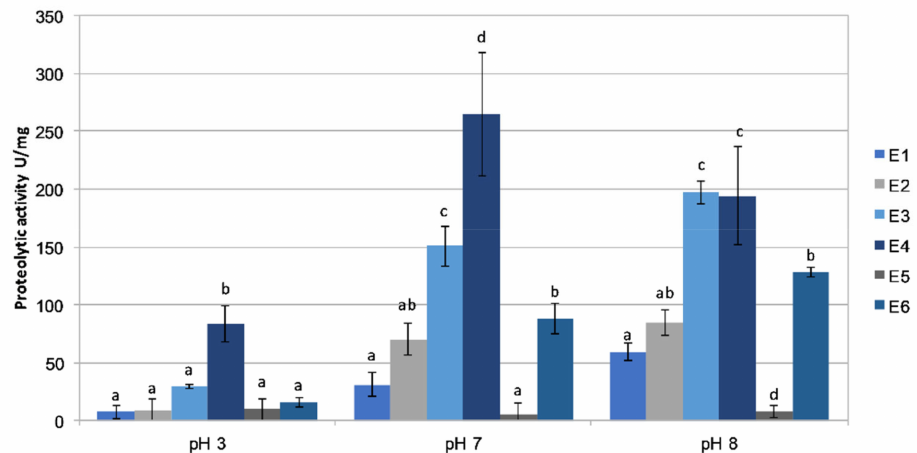
Figure 2. The specific protease activities of the ant nest-carton preparations E1–6 tested in three pH ranges: 3.0, 7.0, and 8.0. The means marked with different letters are significantly different ( p ≤